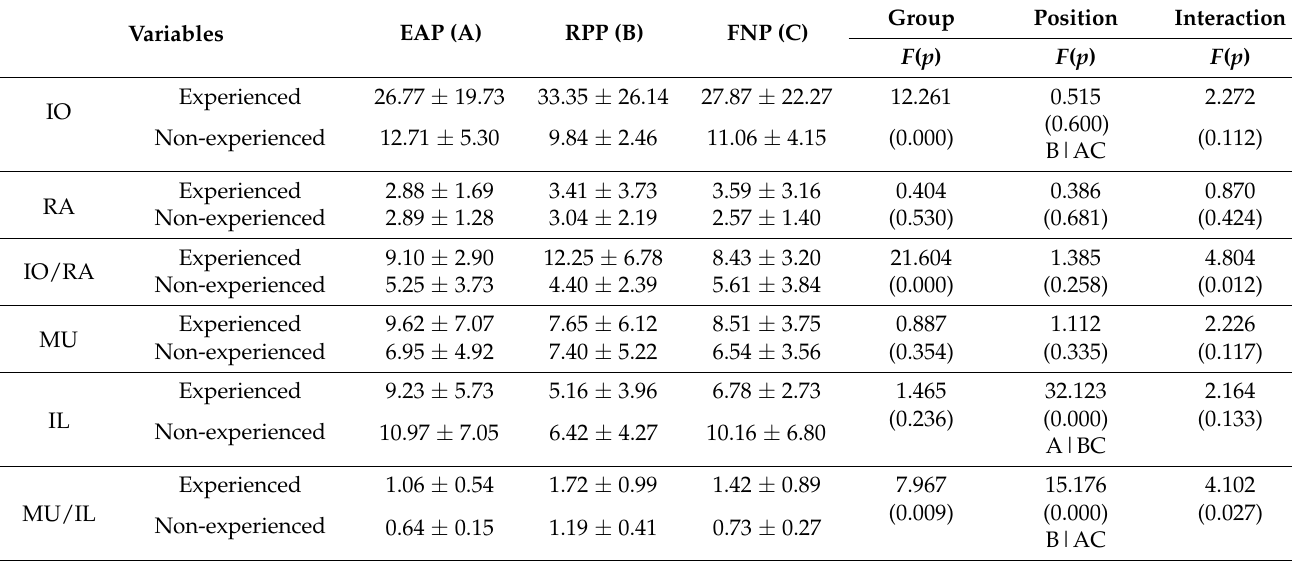
Table 2. Muscle activity during the knee stretch exercise ( µ